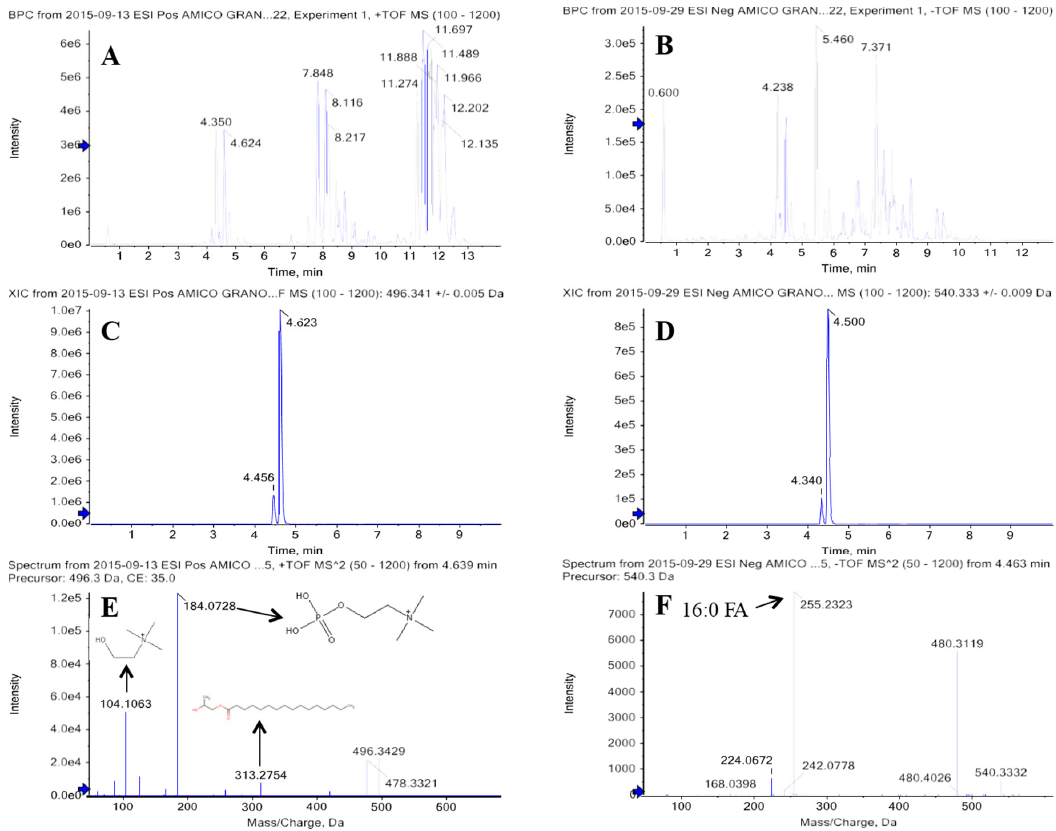
Figure 1. Ultra high performance liquid chromatography coupled to high resolution tandem mass spectrometry base peak chromatograms of ancient wheat extract obtained using positive ( A ) and negative ( B ) ionization modes. Extracted ion chromatogram (XIC) of Lyso PC 16:0 ionized in positive ([M + H] + m / z 496.3399) ( C ) and negative ([M + HCOO] − m / z 540.3332) ( D ) modes. Product ions acquired automatically by the information-dependent acquisition (IDA) method for the m / z 496.3399 ( E ) and m / z 540.3332 ( F ) parent ions. Blue arrows are thresholds and indicators in terms of RT and m / z values.